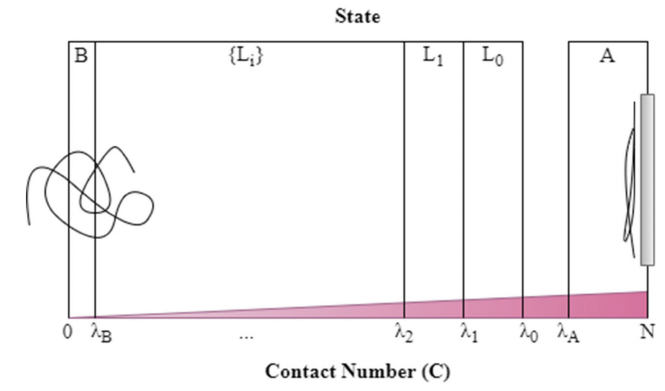
Figure1. Definitionofstates A , L 0 , L 1 , ... , B (shownbyboxes)overtherangeofcontactnumbersbetween 0 and N . State A represents the adsorbed polymer and state B the desorbed polymer. Intermediate transitional states are named L i . State A encompasses contact numbers from N down to 10 or 0.1 N (whichever is